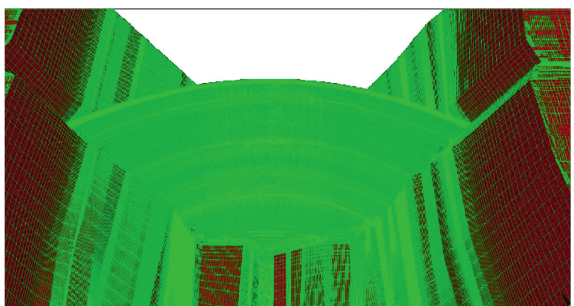
Figure 2: Computational grid diagram (Enlarged Partial